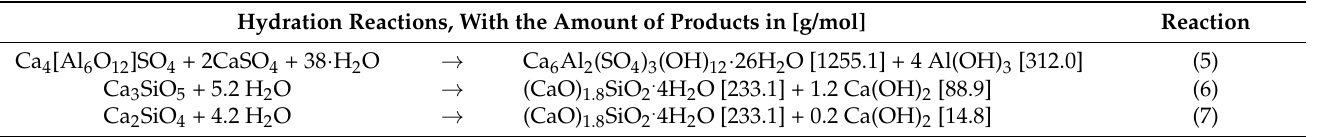
Table 3. Stoichiometries of the hydration reactions for the phases employed in this study [23,33,50]. Hydration Reactions, With the Amount of Products in [g/mol]